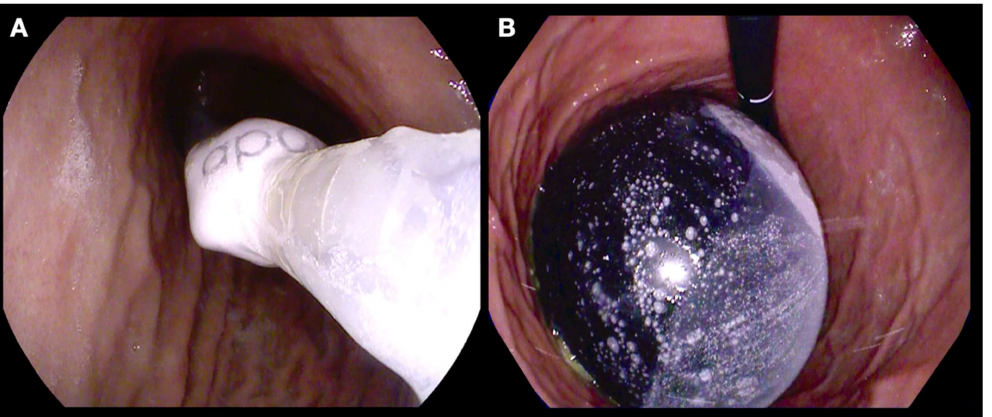
Figure 1. Endoscopic placement of a fluid filled intragastric balloon. ( A ) Endoscopic guided insertion of a gastric balloon catheter; ( B ) an IGB filled with 650 mL of fluid.